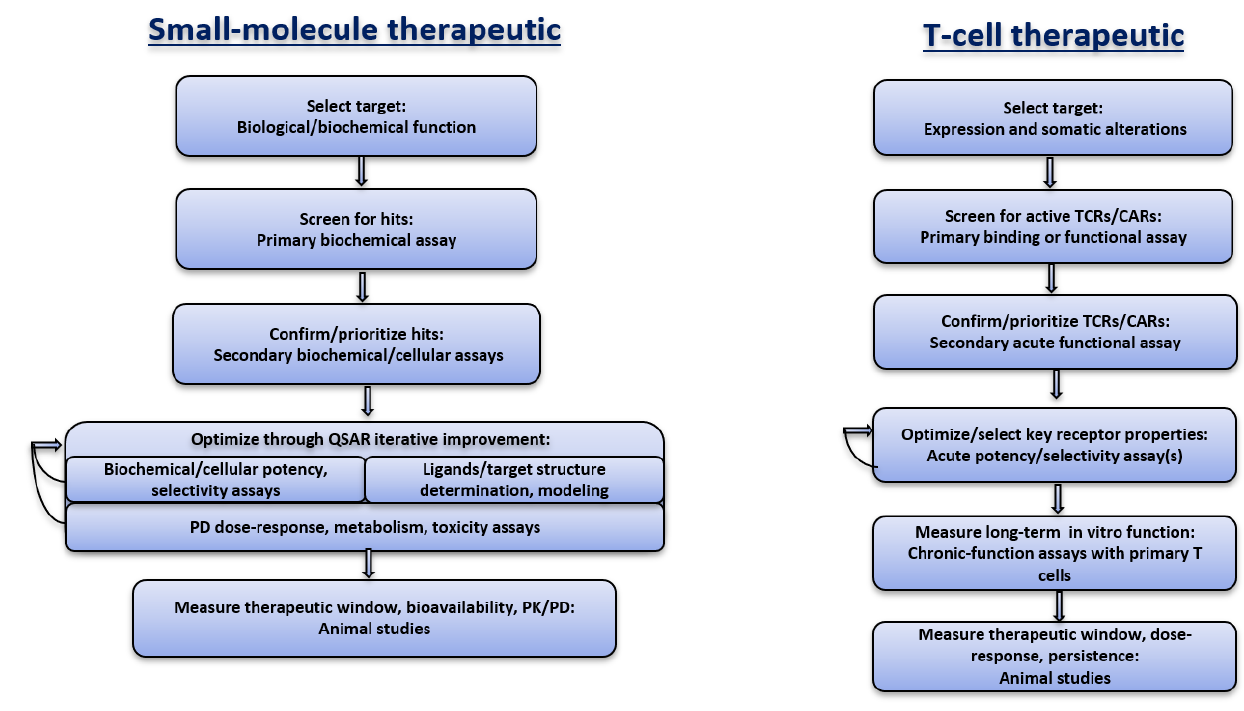
Figure 1. Flow scheme of drug discovery, comparing small-molecule to T-cell therapeutic discovery. QSAR, quantitative structure-activity relationship. The goal is to control variables and improve the predictability of substantive